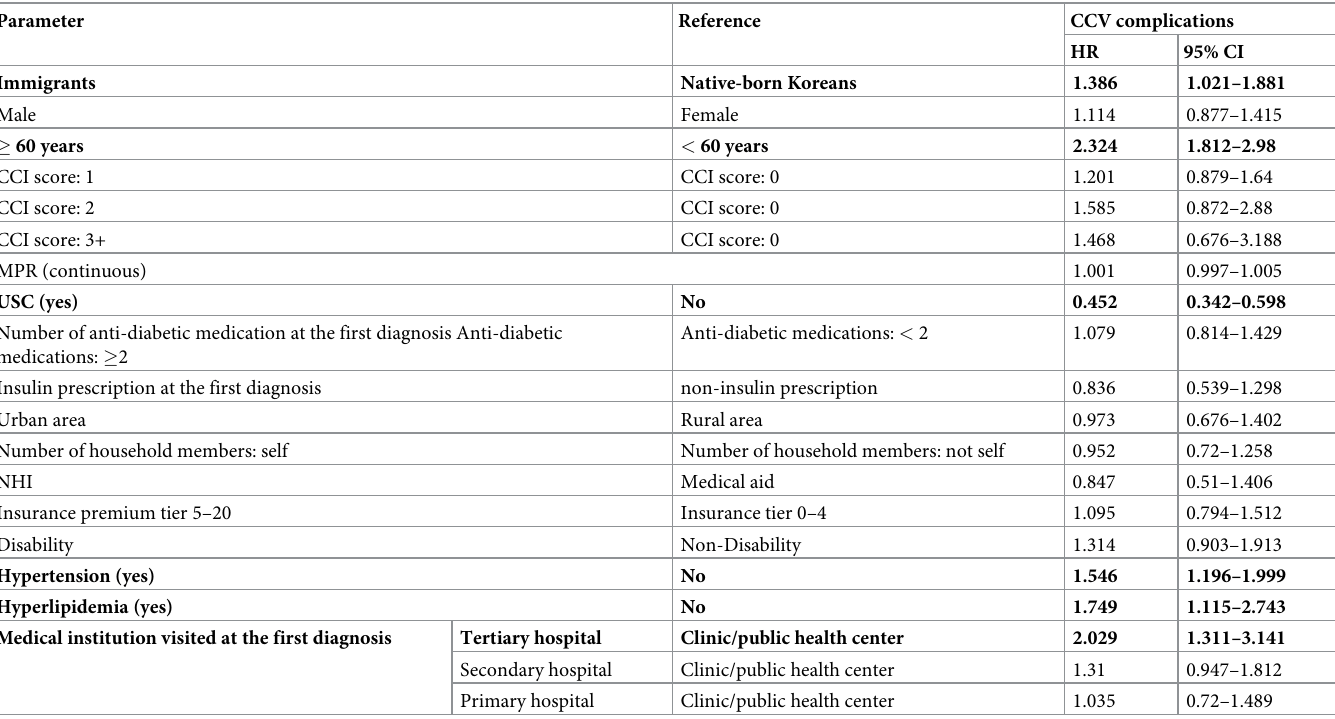
Table 2. Contributing factors for cardio-cerebrovascular complications in all subjects including immigrants and native-born Korean with diabetes. Parameter